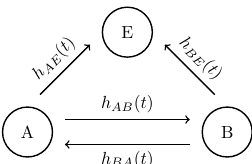
Figure 1: System model: Legitimate nodes A and B mea- sure reciprocal properties of the physical channel, denoted by h and h . A passive attacker E ’s observations BA ( t ) AB ( t ) h AE ( t ) and h BE ( t ) are dependent on its relative position Figure 2: Overview of the core components involved in the and usually correlate less to h and h than h BA ( t ) AB ( t ) BA ( t ) security architecture for key agreement systems from corre- to h . AB ( t ) lated